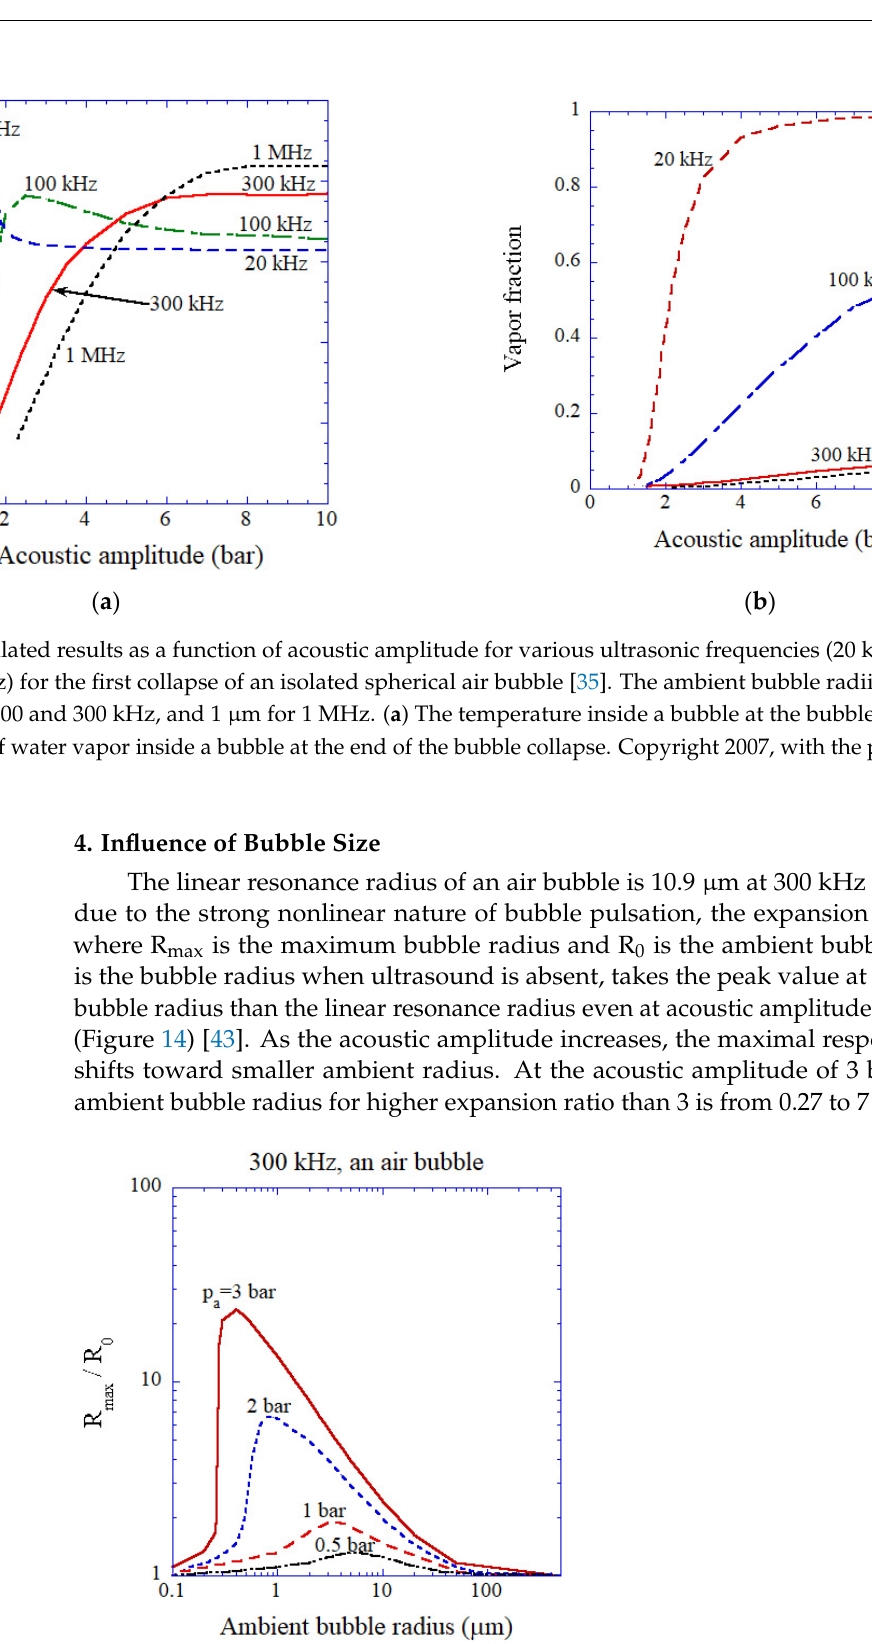
Figure 15. The calculated thresholds for the shape instability, for SL, and for oxidant production as well as the Blake threshold in R 0 -p a plane [43]. Copyright 2008, with the permission of AIP Pub- lishing. The dependence of peak bubble temperature as well as vapor fraction inside an air bubble at the end of the bubble collapse on ambient bubble radius is shown in Figure 16a